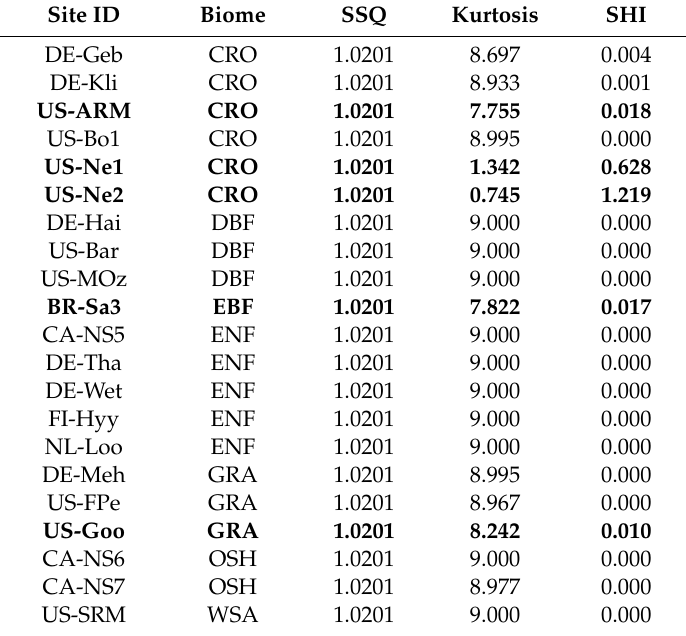
Table 5. Spatial heterogeneity index (SHI) for di ff erent flux sites. Letters in bold indicate SHI for heterogeneous sites.